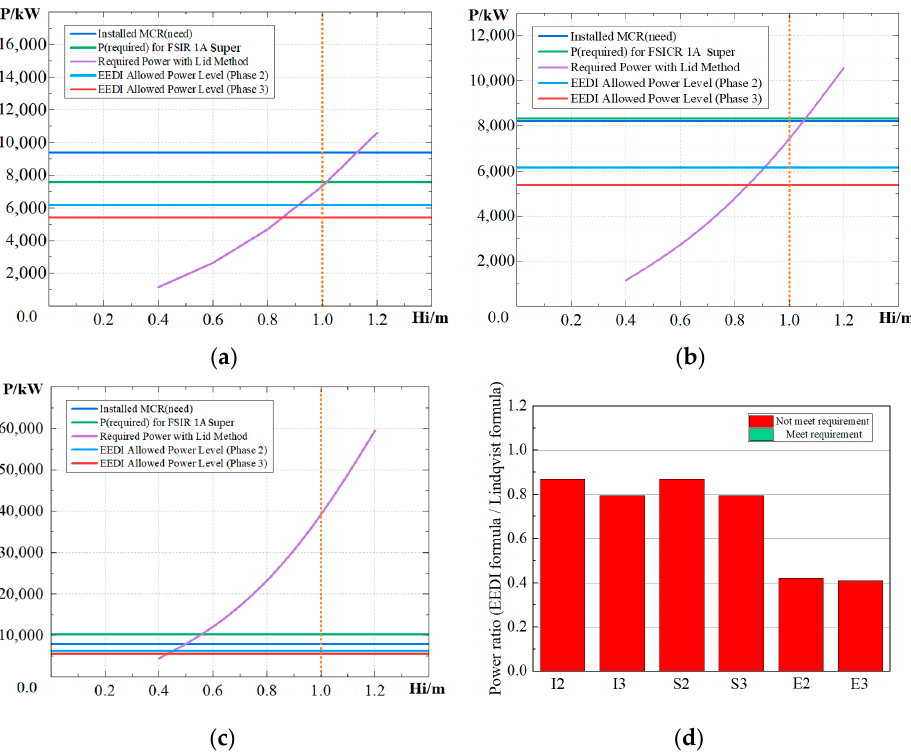
Figure 8. Power requirement results for 1A super. ( a ) Power of traditional icebreaker bow, ( b ) Power